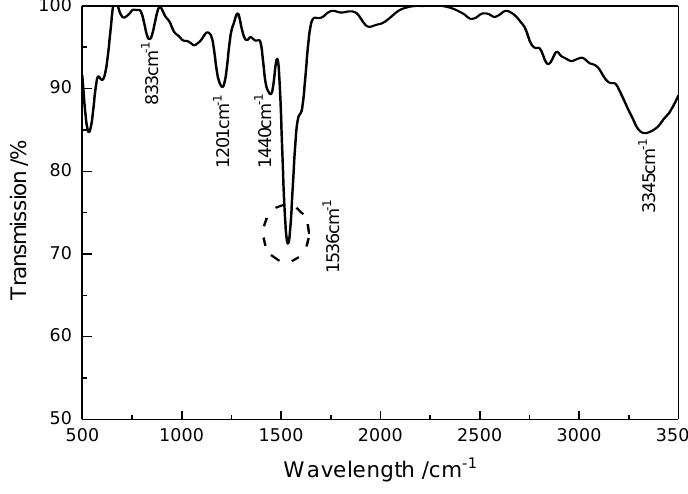
Figure 2. The IR characterization of HMDA